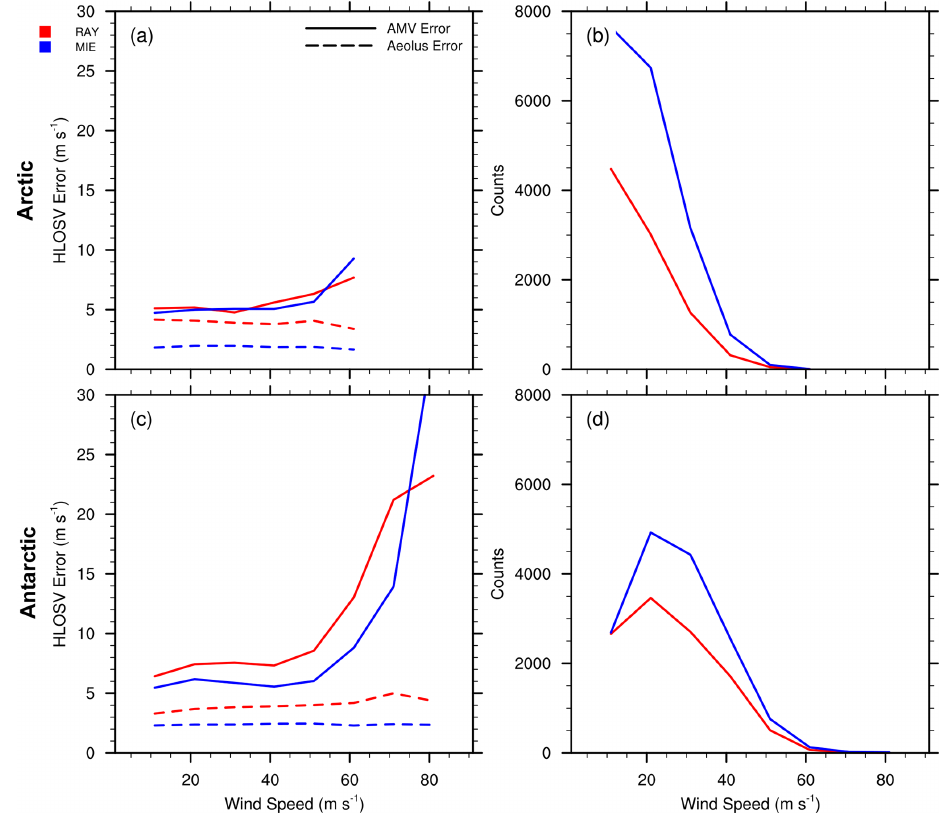
Figure 14. As in Fig. 8 but for LEO IR RAY and MIE comparisons at the